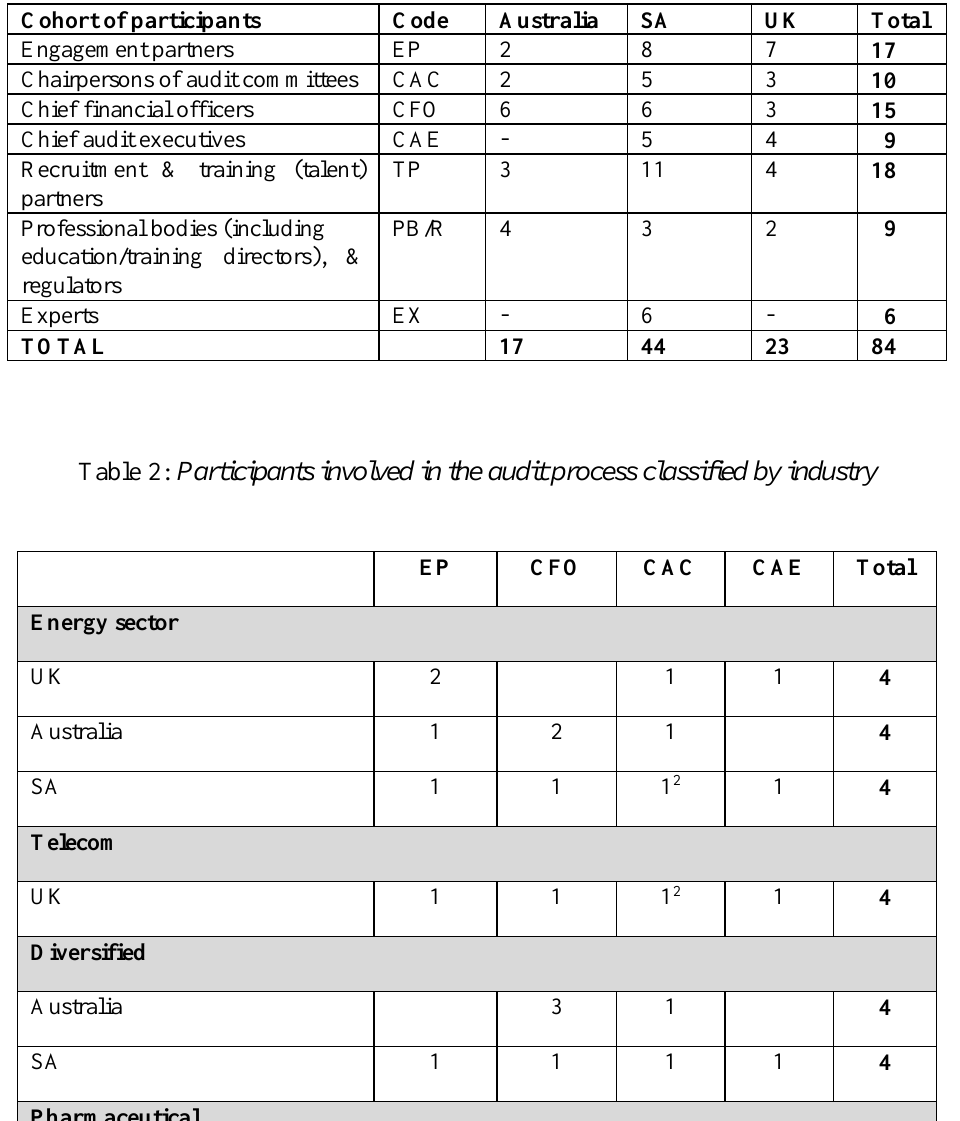
Table 1: Number of participants